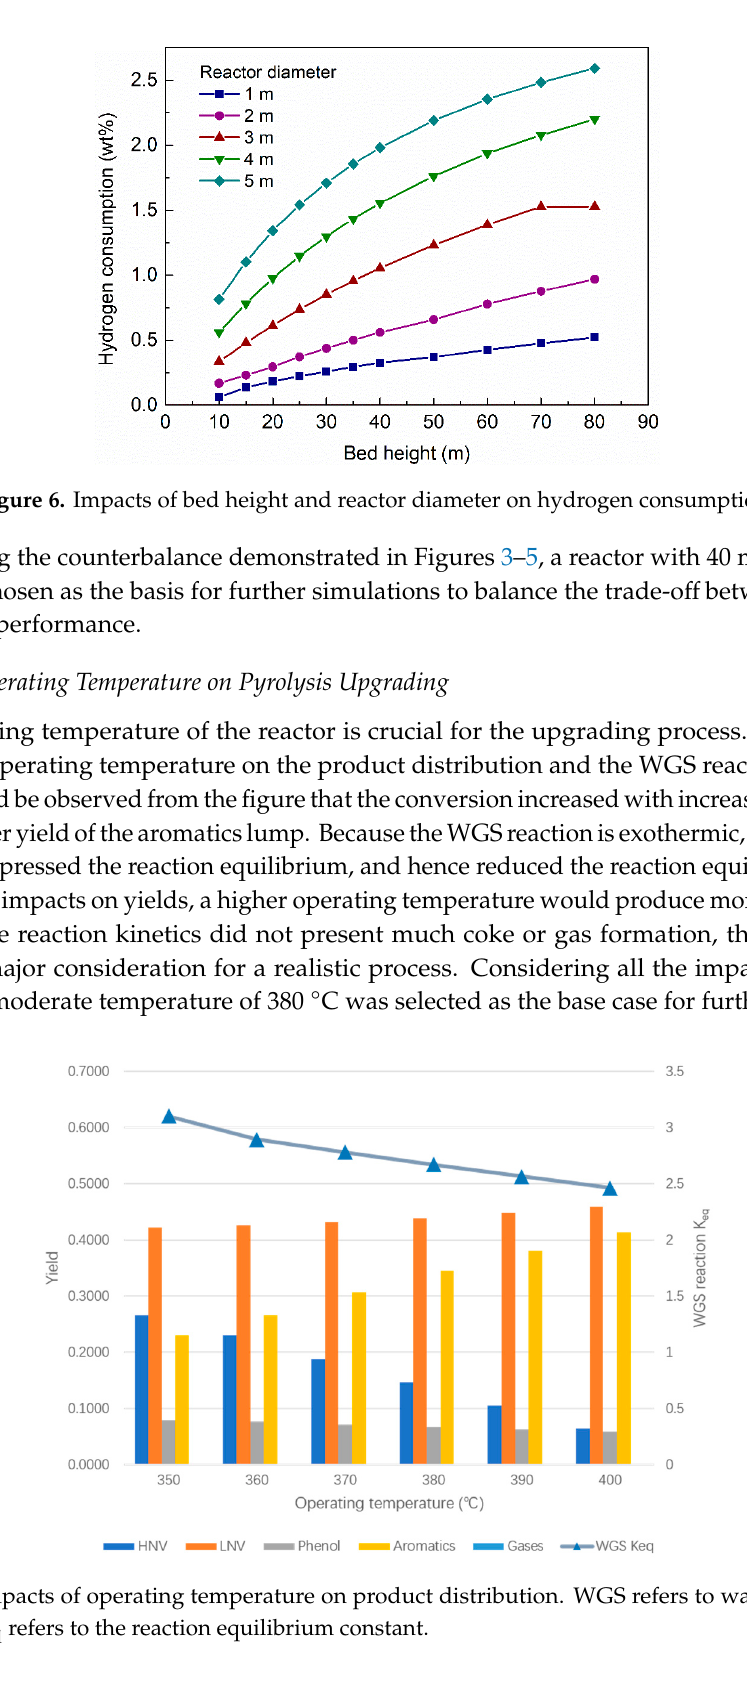
( b ) Figure 8. Impacts of syngas cut ratio and membrane area on syngas hydrogen purity. ( a ) Area of membrane-202 was 5000 m 2 ; ( b ) area of membrane-202 was 10,000 m 2 .